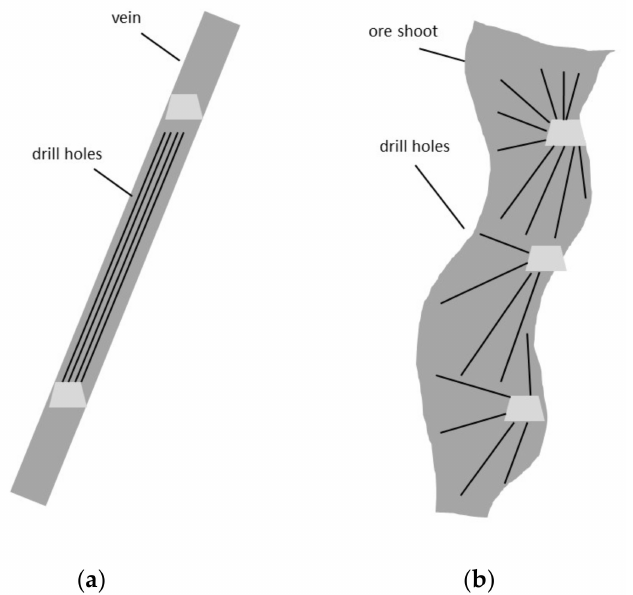
Figure 4. Schematic mining methods for ( a ) a narrow vein with clear hanging and foot walls and ( b ) an irregular ore